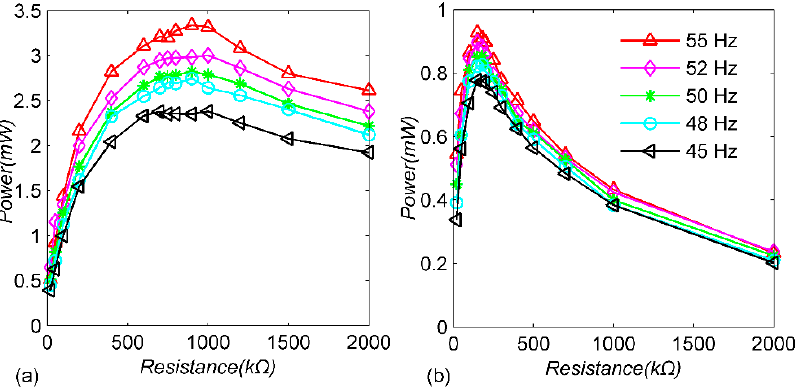
Figure 8. Experimental harvested power for different excitation frequencies and load values in the constant-displacement case: ( a ) SSHI-PBMS circuit; ( b ) standard circuit.